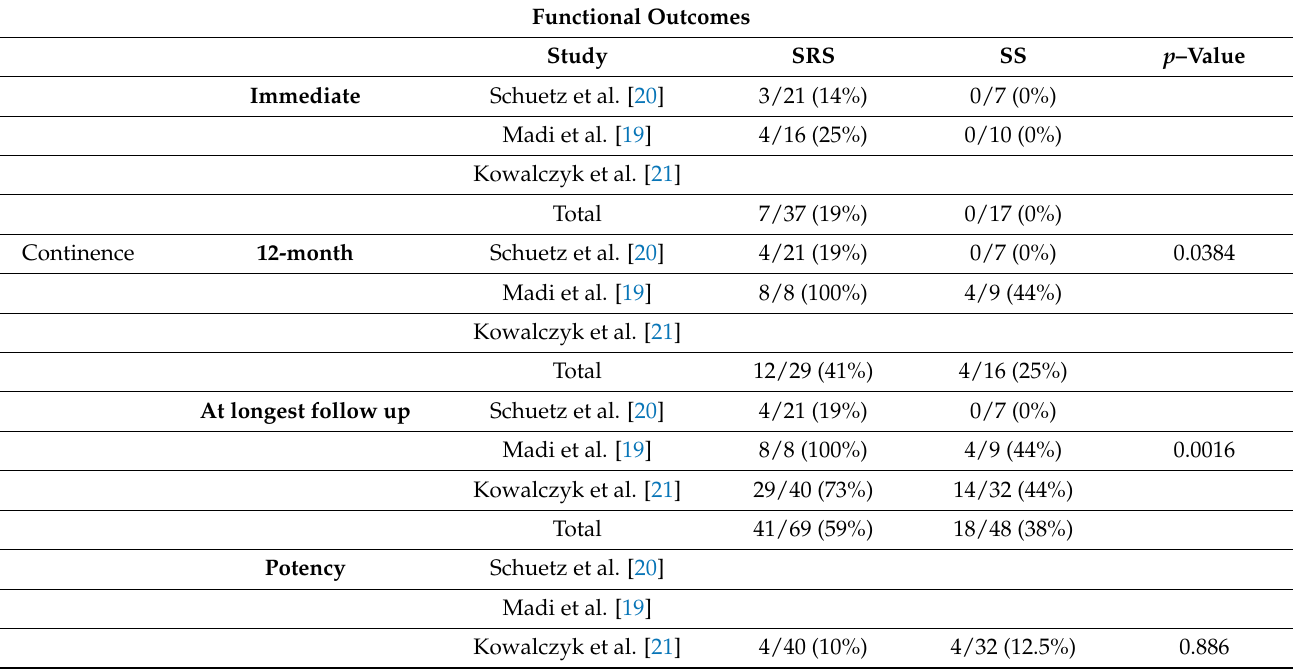
Table 3. Functional Outcomes. Immediate continence after catheter removal was seen in 19% of SRS and 0% of SS. Continence at 12 months was seen in 41% of SRS and 25% of SS, and 59% of SRS at longest follow-up compared to 25% of SS. Potency was 10% in SRS and 12.5% of SS when reported. Functional Outcomes